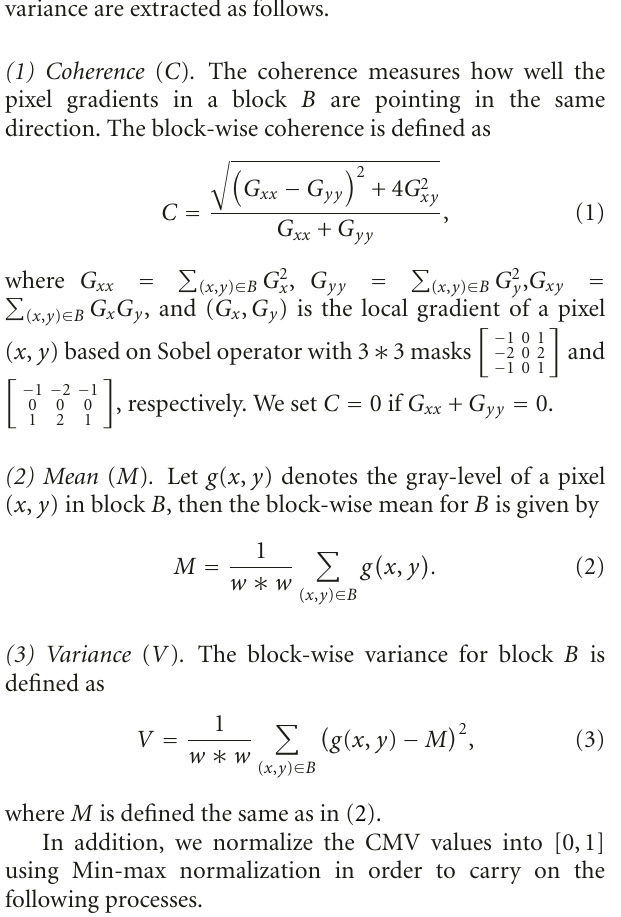
Table 2: Average number of foreground and background blocks over the 10 images selected from each